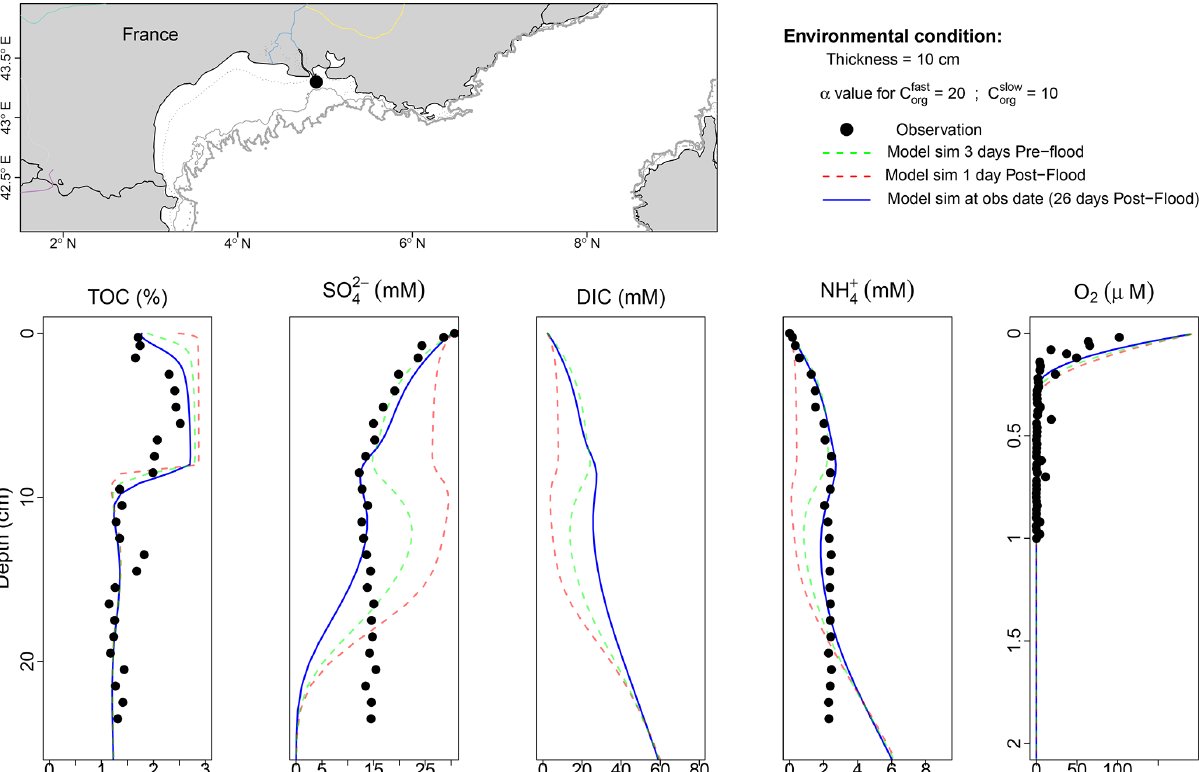
Figure 4. Model and observation depth profile of TOC (%), SO 2 − prodelta). The green and red dashed lines depict the vertical depth profile of the model before (3d) and after (1d) the flood deposit. The blue solid line represents the model result on the day the observations were collected (26d after the flood, as indicated by the black circle).